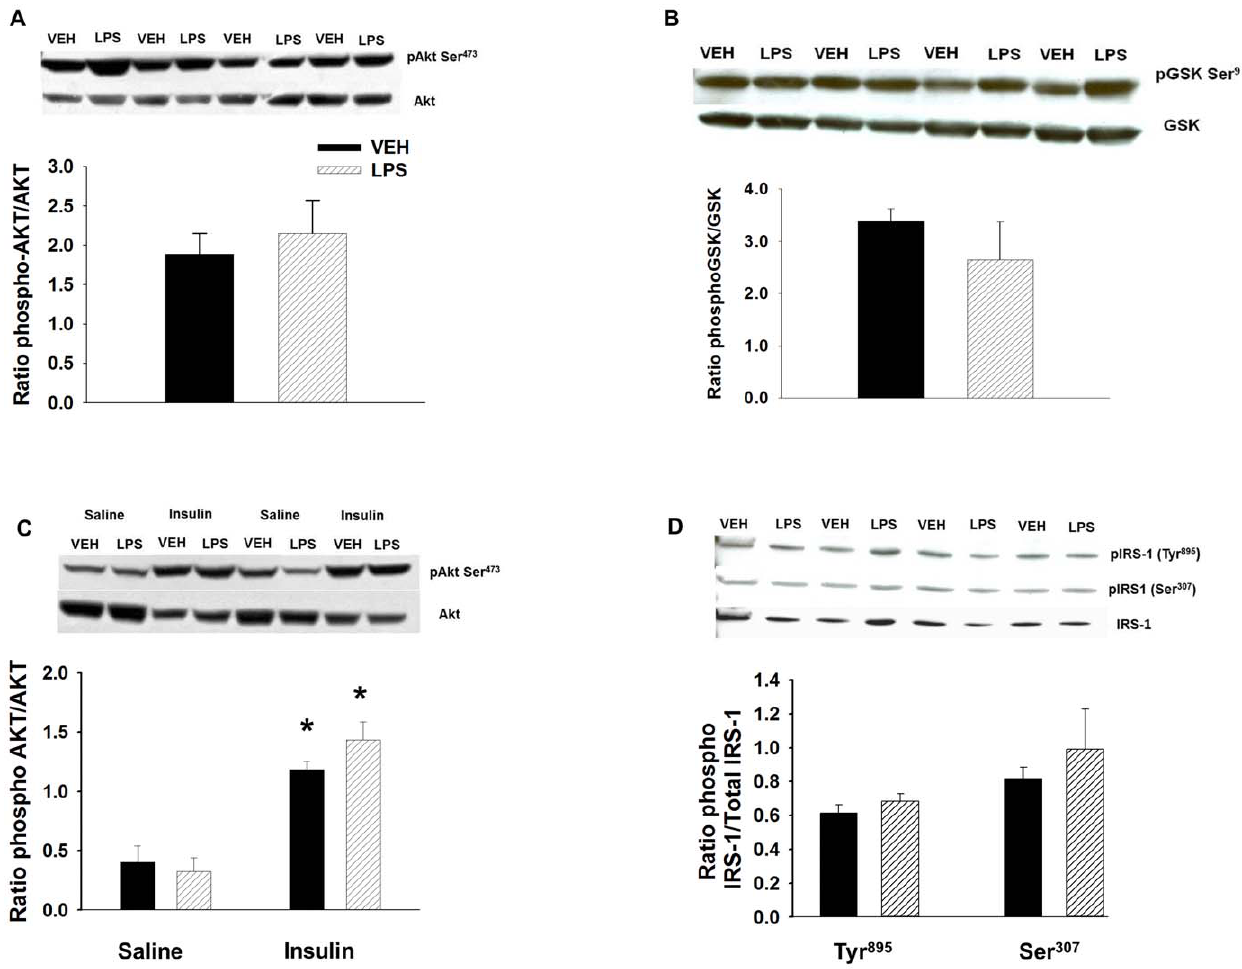
Figure 5. Effect of vehicle and LPS treatment on insulin signaling. Akt phosphorylation (Ser 473 ; Panel A) and GSK phosphorylation (Panel B) in the gastrocnemius muscle of C57/BL6j mice that received vehicle (VEH) or high-dose LPS (HD LPS; 10 m g/gBW) after a hyperinsulinemic-euglycemic clamp. Akt phosphorylation (Ser 473 ; Panel C) and phosphorylation of IRS-1 (Tyr 895 and Ser 307 ; Panel D) in the gastrocnemius muscle of C57/BL6j mice after an acute bolus of saline or insulin. Data are expressed as mean 6 SEM. *p , 0.05.